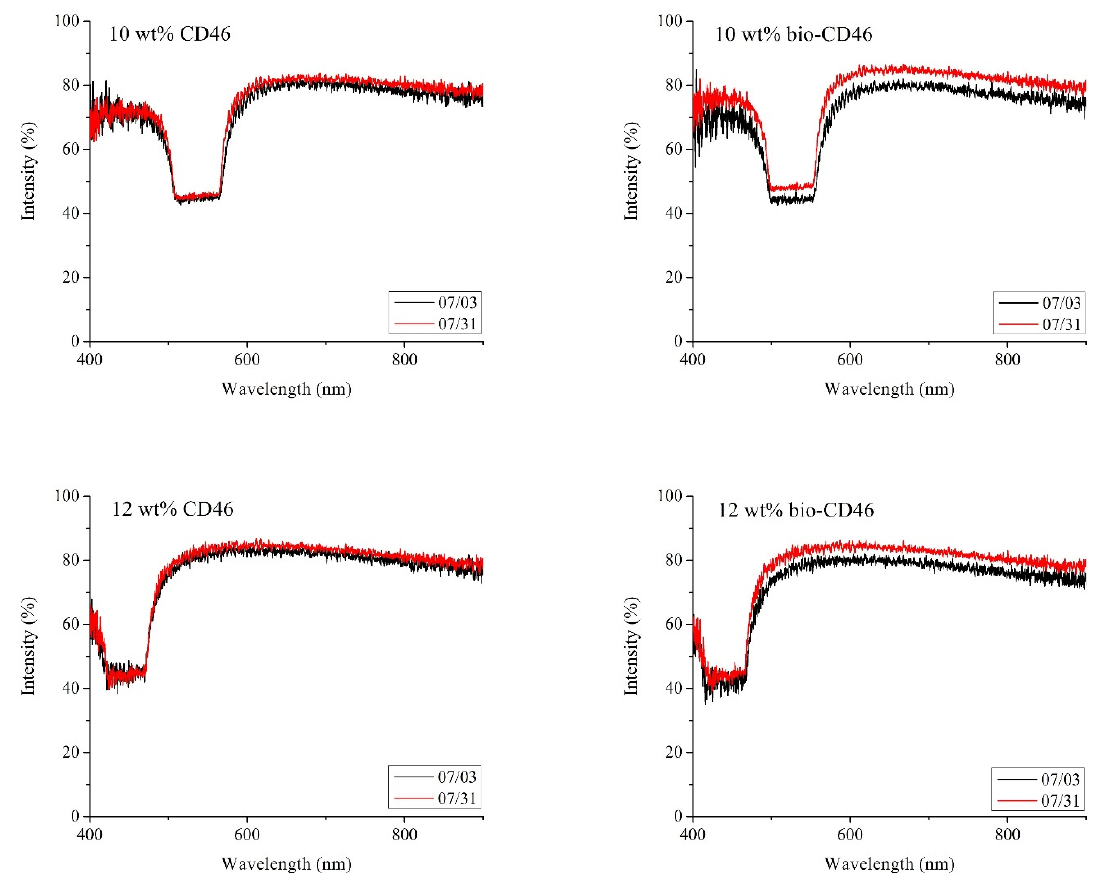
Figure 8. Transmission spectra of 12 wt.% and 10 wt.% of CD46 and bio-CD46 mixtures for an interval of 28 days. No considerable wavelength shift is observed. The slight increase in the transmitted intensity is due to the decrease in defect density with time.